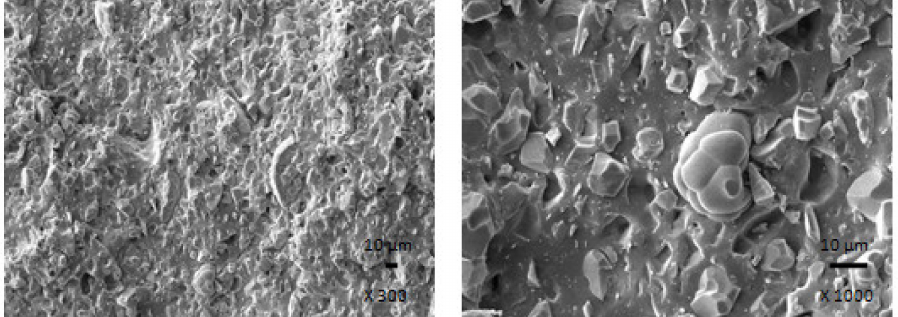
Figure 16. SEM images of composite containing 300 phr of ferrite.